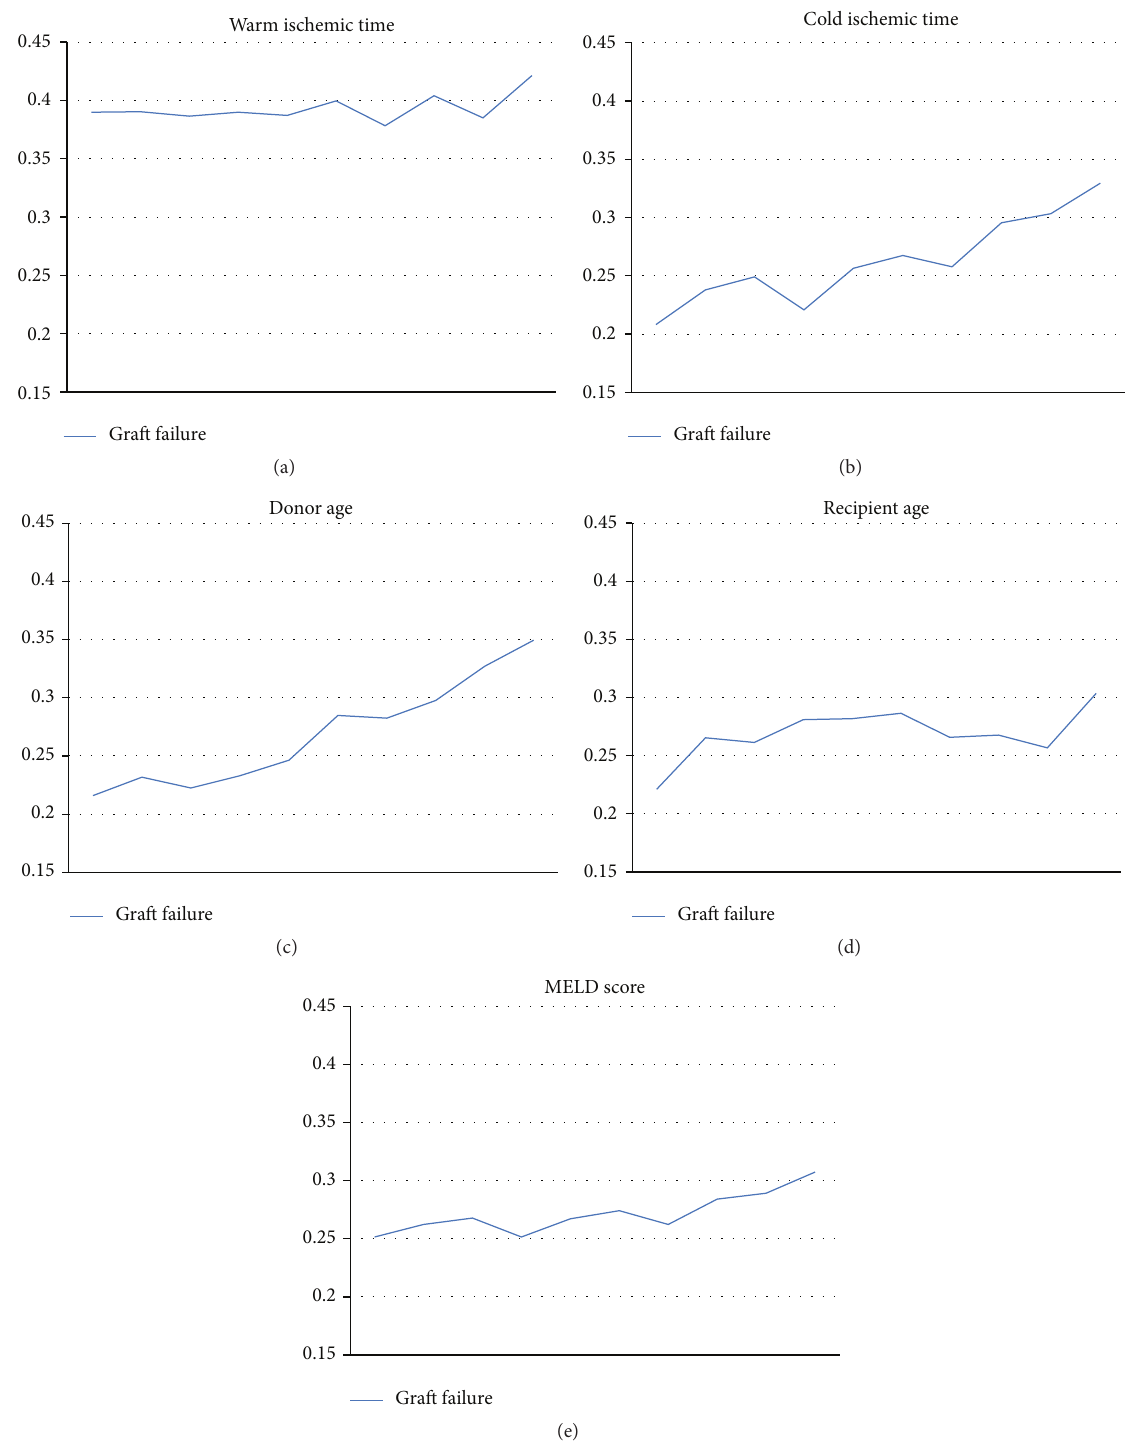
Figure 1: Unadjusted contributions of continuous factors to risk of graft failure. (a) Warm ischemic time (WIT). On multivariate analysis, risk of graft failure increases by 0.2% per minute ( 𝑝 = 0.03 ). (b) Cold ischemic time (CIT) contributes to 2.4% increased graft failure risk per hour. (c) Donor age increases graft failure risk by 0.4% per year of age. (d) Recipient age contributes to 0.5% per year of age. (e) Graft failure rates increase by 0.9% per MELD